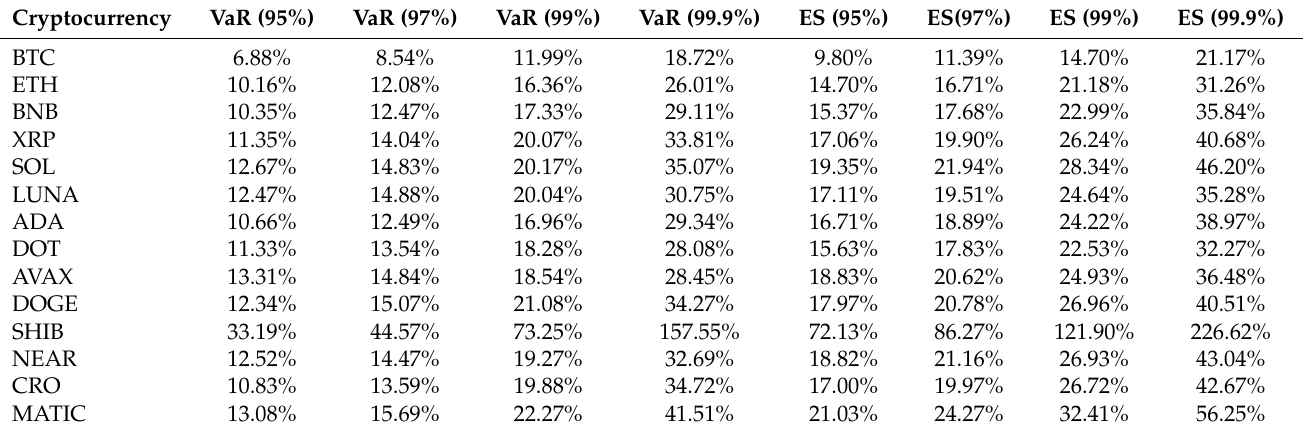
Table 6. Risk measures of the cryptocurrency return distributions based on the GARCH-EVT process.